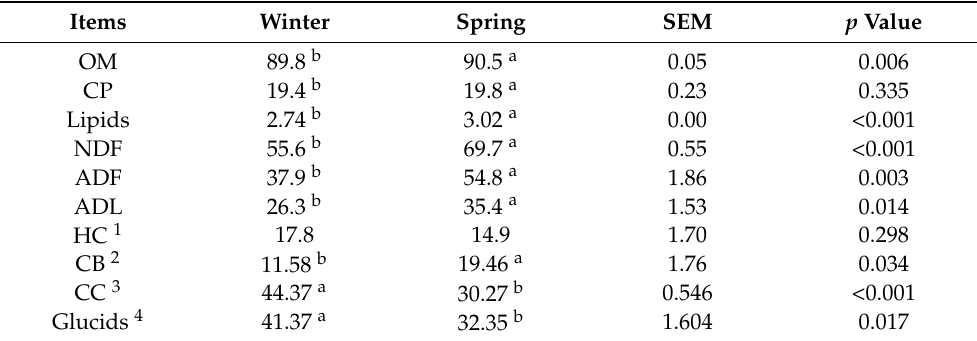
Table 1. Seasonal variation in chemical composition (% DM) of Paulownia shan tong harvested in winter and